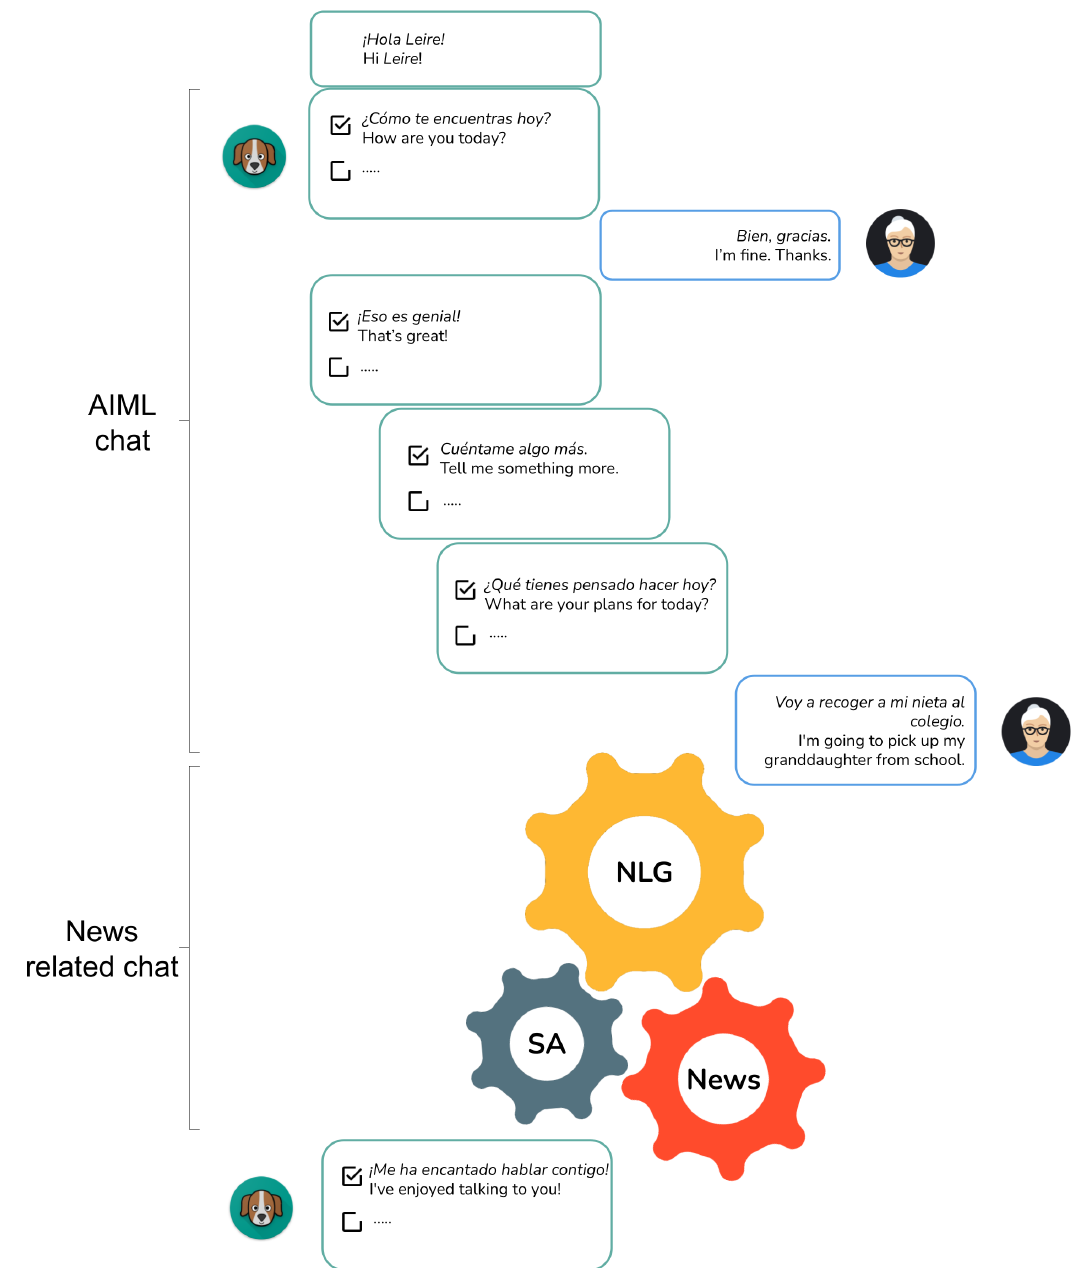
Figure 5. Dialogue flow